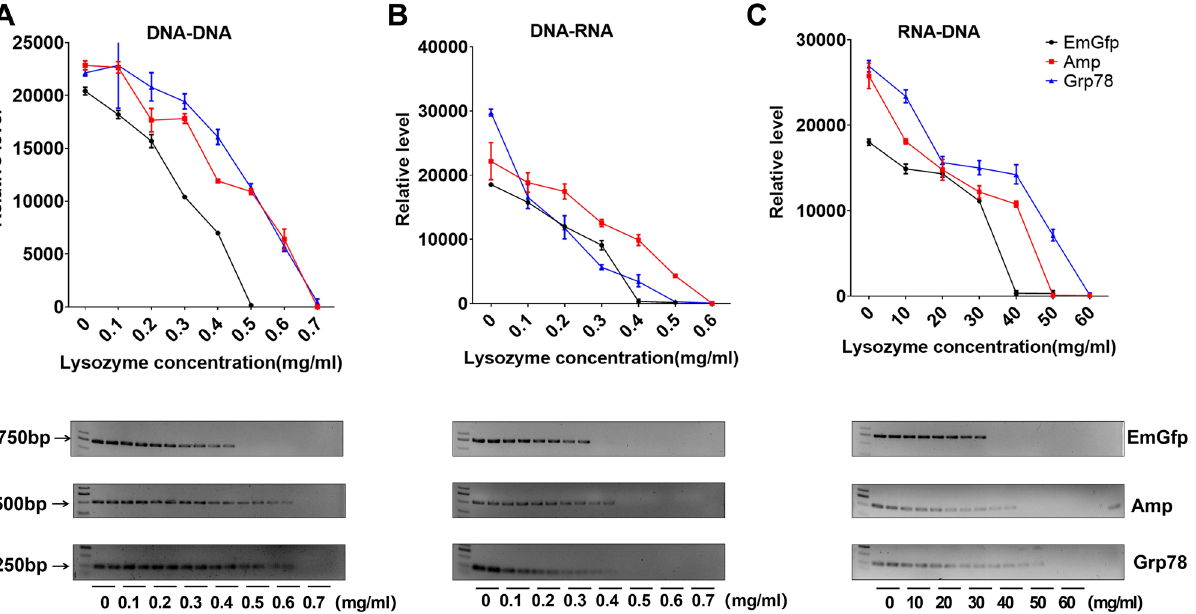
Figure 1. Lysozyme blocks EmGfp, Amp and Grp78 DNA replication, transcription and reverse transcription. ( A ) – ( C ) Gel electrophoresis of PCR products. Lysozyme at the corresponding working concentration was added to each reaction system. ( A ) Replication, ( B ) transcription and ( C ) reverse transcription. Intensity analysis of target bands in gel electrophoresis is shown at the top of the blot, original blots/gels are presented in Supplementary data (PCR-full-length immunoblots). Data are representative of 2 independent experiments and presented as the mean ± SD; * p < 0.05, *** p < 0.001. Significant differences were evaluated using one-way ANOVA with a post hoc test (Fisher’s least significant difference).